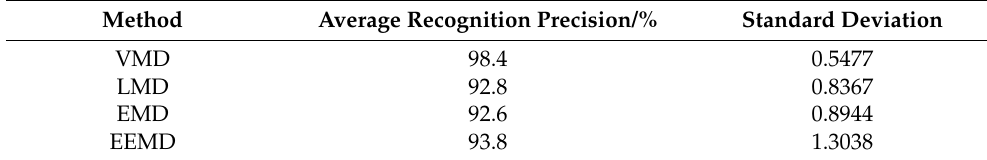
Figure 18. K-cross-validation experiment results. Table 8. Average recognition precision and calculation times of the four classifiers. Classifier Average Recognition Preci- sion/%